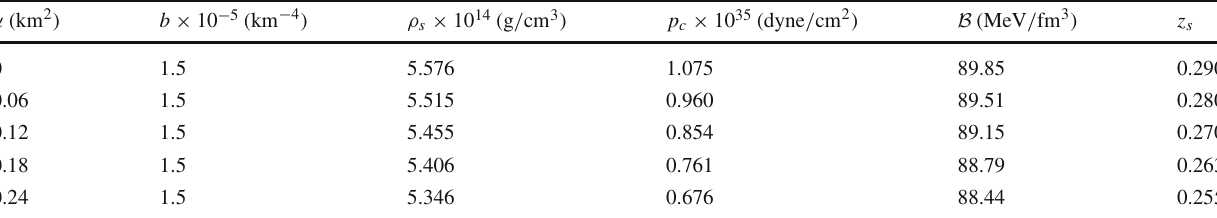
Table 1 Values of all the parameters corresponding to different values of α and for M = 1 . 97 M (cid:3) , R = 9 . 69km α ( km 2